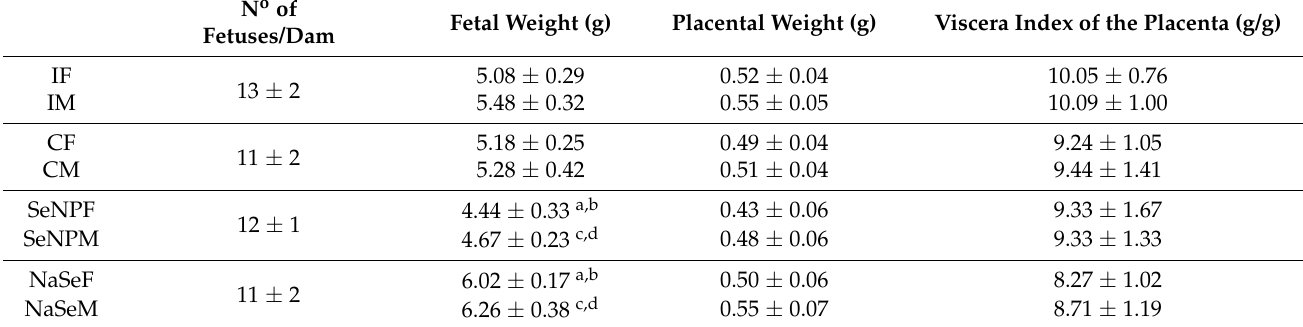
Table 1. Fetal weight (g), placental weight (g) and viscera index of the placenta (g/g) after the treatment of pregnant females with SeNPs and sodium selenite. ICF—intact females; ICM—intact males; CF—control females; CM—control males; SeNPF—nano Se females; SeNPM—nano Se males; NaSeF—sodium selenite females; NaSeM—sodium selenite males. Significant differences between groups: a in respect to ICF; b in respect to CF; c in respect to ICM; d in respect to CM. p < 0.05 was considered as